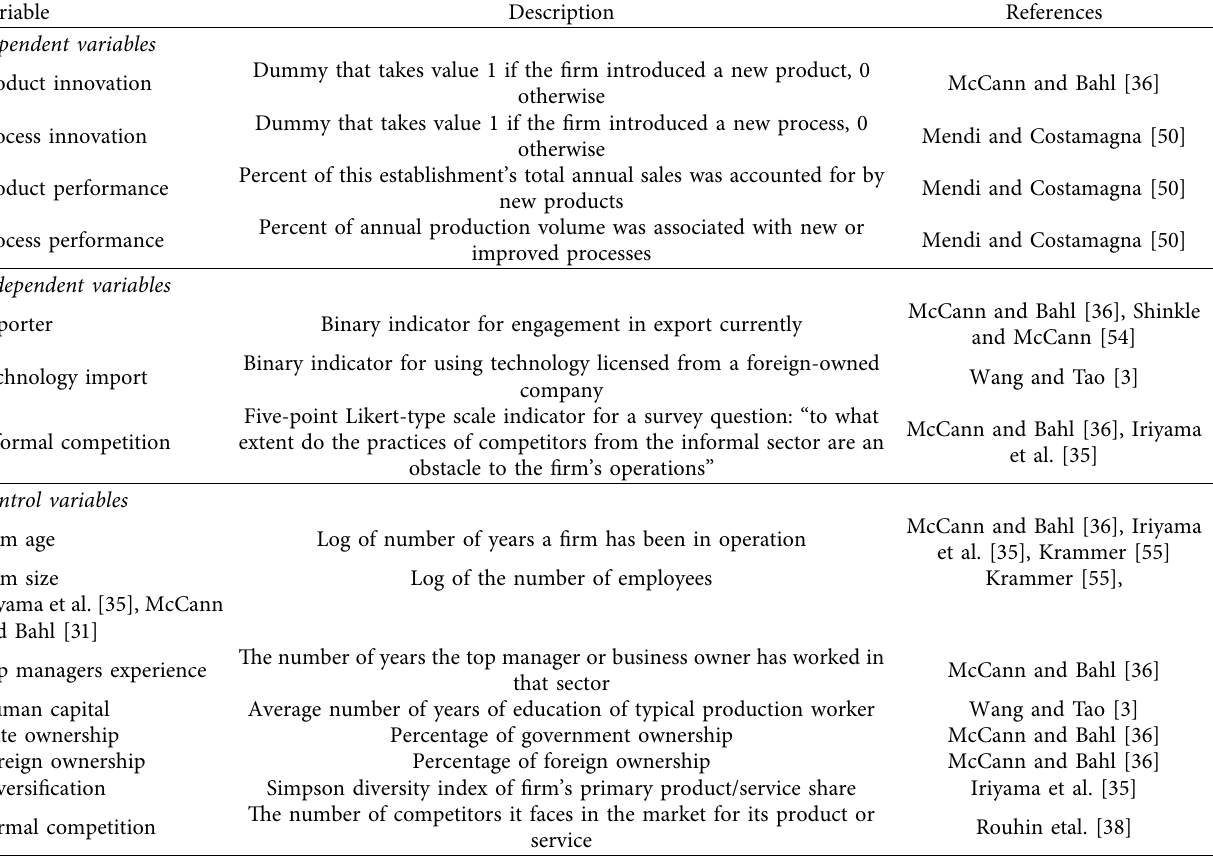
Table 1: Variable